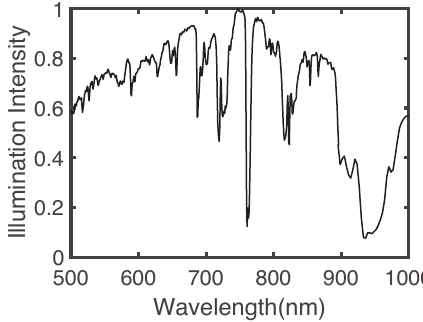
Figure 6. Illumination